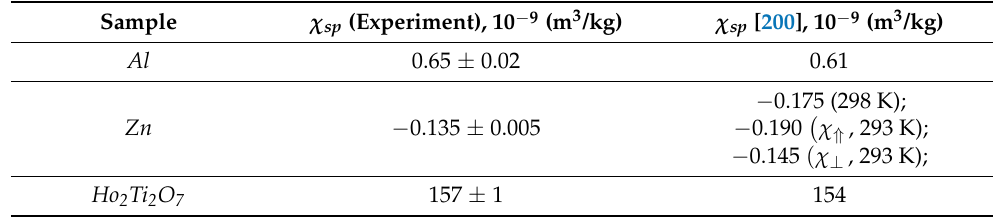
Table 9. Magnetic susceptibility of test samples.